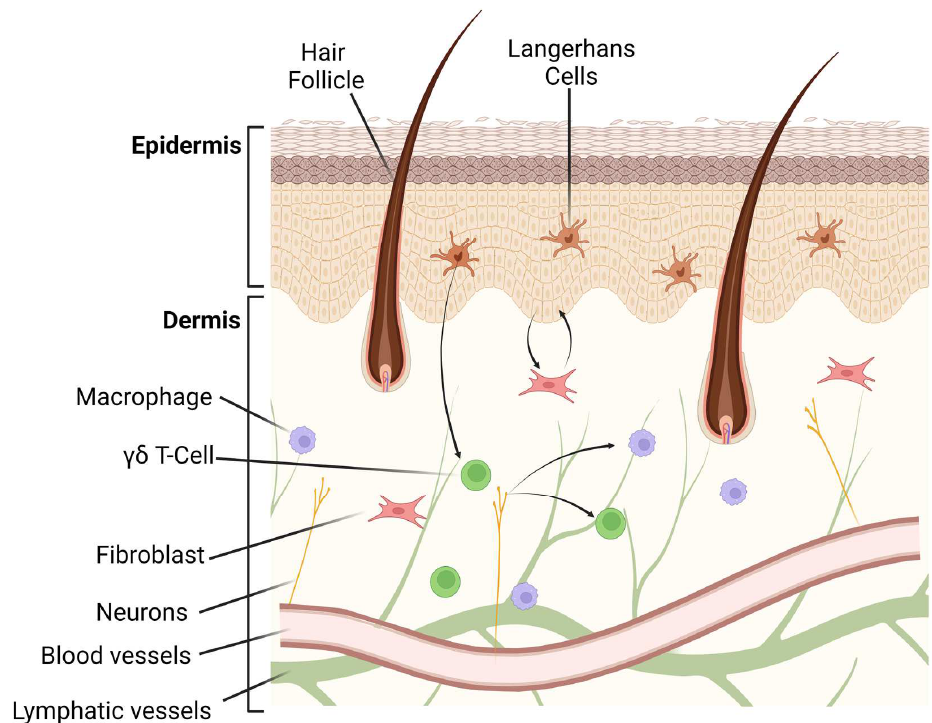
Figure 1. Illustration of skin components and their cell